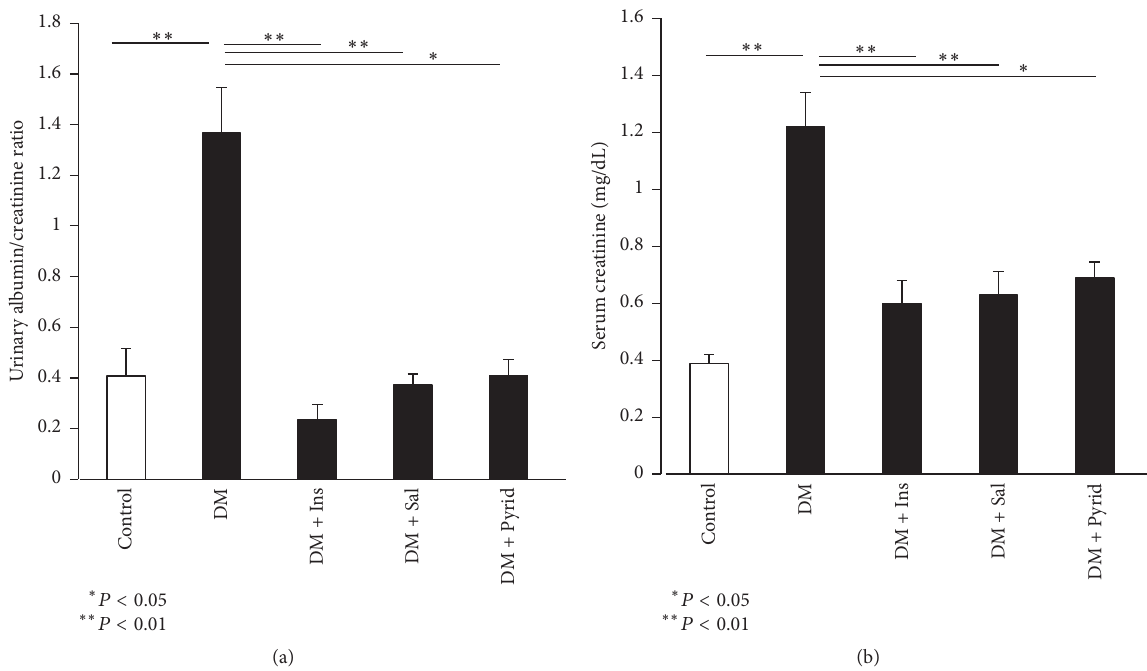
Figure 2: Albuminuria and serum creatinine levels. Albuminuria was evaluated as urinary albumin-creatinine ratio (ACR) in nondiabetic control (Control), diabetic mice without treatment (DM), diabetic mice with insulin treatment (DM + Ins), diabetic mice with salicylate treatment (DM + Sal), and diabetic mice with pyridoxamine treatment (DM + Pyrid) (a). Serum creatinine levels (mg/dL) (b). Control ( 𝑛 = 8 ), DM ( 𝑛 = 19 ), DM + Ins ( 𝑛 = 8 ), DM + Sal ( 𝑛 = 12 ), and DM + Pyrid ( 𝑛 = 15 ). Values are mean ±